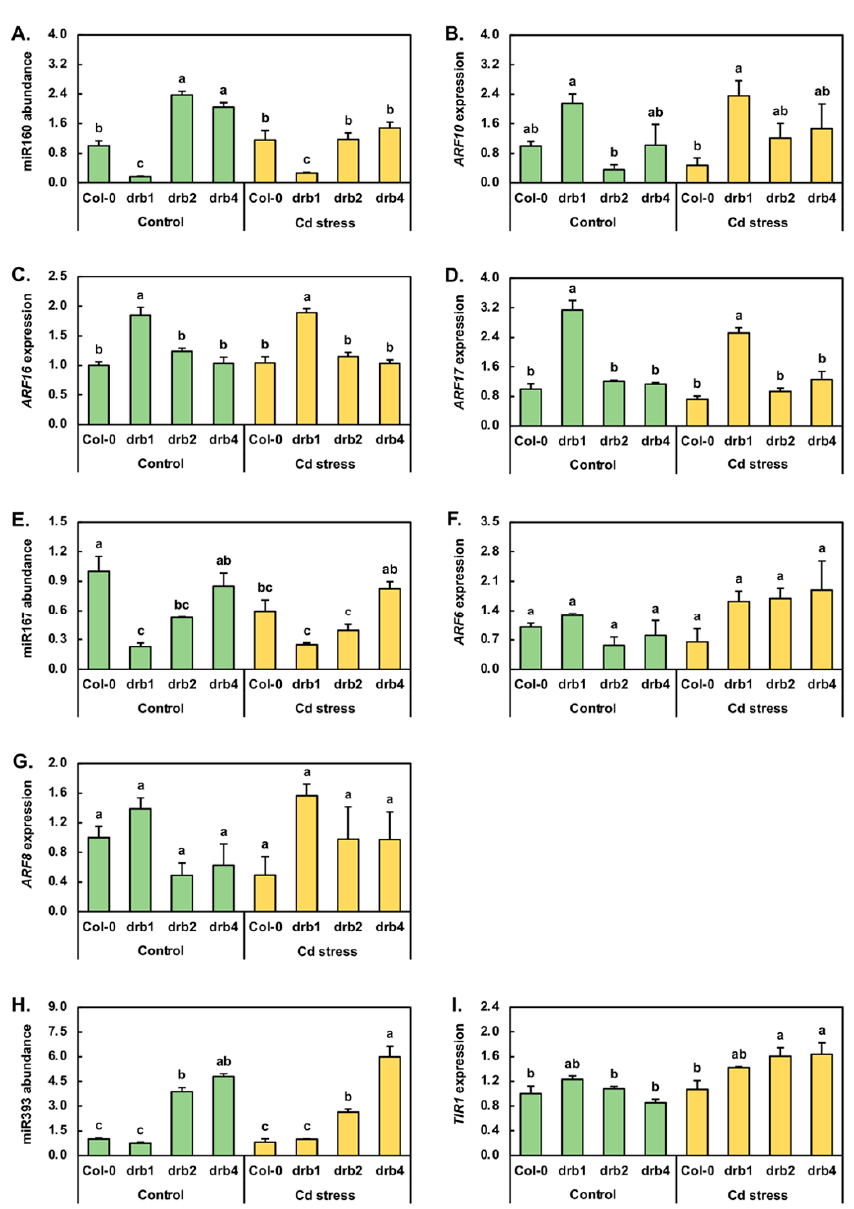
Figure 3. Molecular profiling of the expression modules of three auxin pathway-specific microRNAs following the exposure of Col-0, drb1 , drb2 and drb4 plants to cadmium stress. RT-qPCR quantification of miR160 abundance ( A ) and the expression of its target genes, ARF10 ( B ), ARF16 ( C ) and ARF17 ( D ), in 15-day-old control and Cd-stressed Col-0, drb1 , drb2 and drb4 plants. RT-qPCR quantification of miR167 abundance ( E ) and of the expression of its ARF target genes, ARF6 ( F ) and ARF8 ( G ), in 15-day-old control and Cd-stressed Col-0, drb1 , drb2 and drb4 plants. Profiling of miR393 abundance ( H ) and of the expression of its primary target gene, TIR1 ( I ), in control and Cd-stressed Col-0, drb1 , drb2 and drb4 whole seedlings by RT-qPCR. ( A – I ) Statistical data were analyzed using one-way ANOVA and Tukey’s post-hoc tests. The statistically significant differences are indicated by a different letter ( p -value < 0.05) above each column of each histogram.